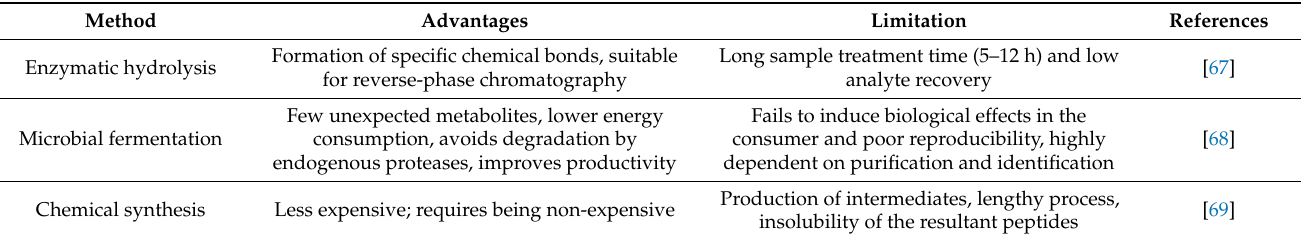
Table 1. Advantages and limitations of protein/peptide extractions and formation